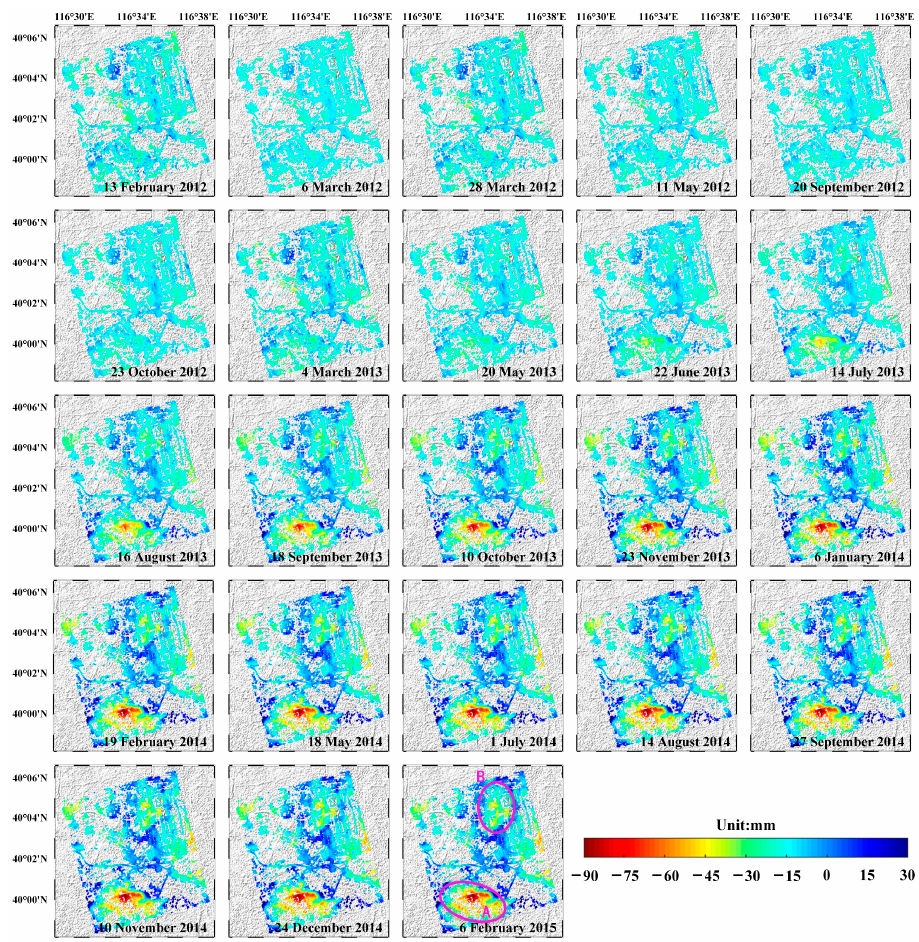
Figure 7. Time-series deformation results over the study area (with reference to 22 January 2012; Areas A and B were two typical subsiding areas.).